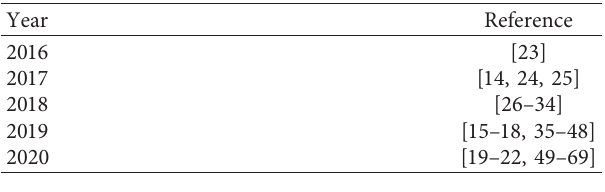
Table 1: Materials published in the given years.